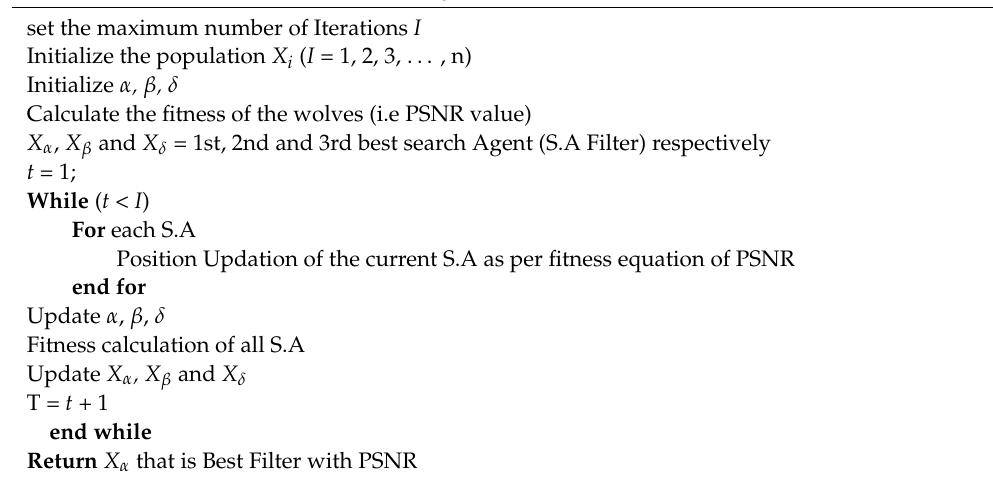
Algorithm 1. Pseudo-code of the GWO